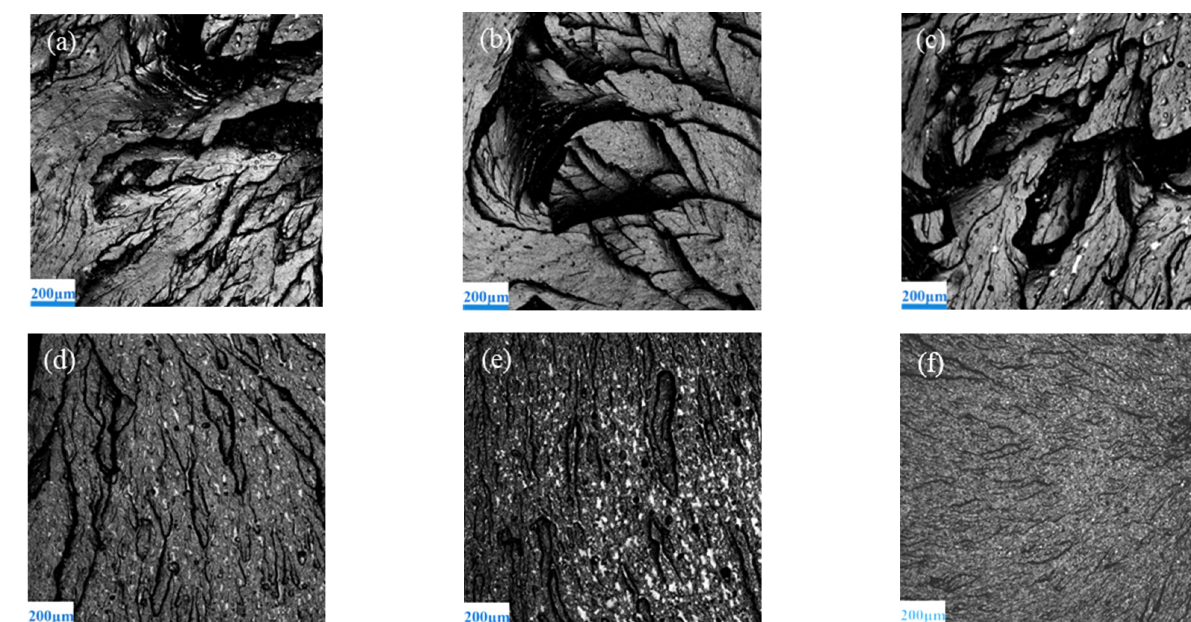
Figure 8. Tensile fracture morphology of alumina reinforced coatings: ( a ) MA50-5, ( b ) MA50-15, ( c ) MA50-20, ( d ) NA30-5, ( e ) NA30-15, ( f ) NA30-20.